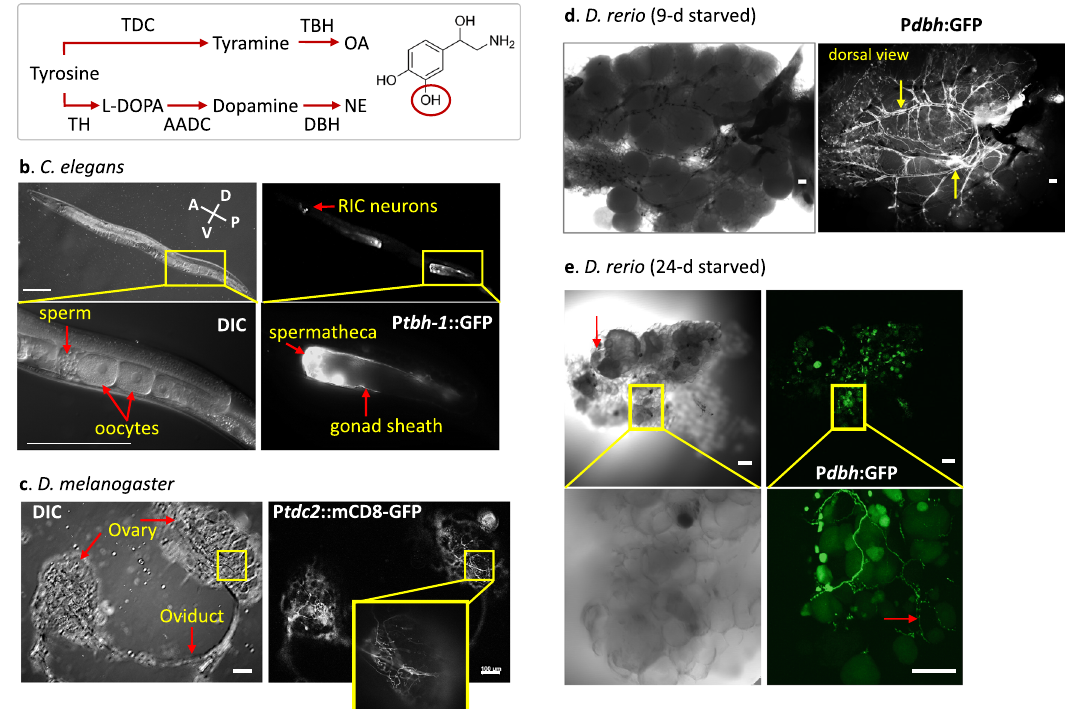
Fig. 1 Noradrenergic innervation of ovaries in the three animals. a The synthesis pathways of norepinephrine (NE) and octopamine (OA) and the enzymes for each step. TDC: Tyrosine decarboxylase, TBH: Tyramine β -hydroxylase, TH: Tyrosine hydroxylase, AADC: Aromatic L-amino acid decarboxylase, DBH: Dopamine β -hydroxylase, L-DOPA: L-Dihydroxyphenylalanine. NE is shown. The hydroxyl group (red circle) is absent in OA. b GFP driven by a tbh-1 promoter (P tbh-1 ::GFP) is expressed in the gonadal sheath cells and the spermatheca in addition to RIC interneurons in the head of a 1-day old adult C. elegans . All 15 C. elegans examined showed similar expression pattern. The left panel shows developing oocytes surrounded by gonadal sheath (top) and the enlarged image of the inset in a DIC image (bottom). The right panel shows the GFP expression of tbh-1 . The highest expression is observed in the spermatheca and the proximal three pairs of the gonadal sheath cells that surround diakinesis-staged oocytes. GFP is also expressed in a pair of RIC neurons in the head. c The expression of a tdc2 - GAL4 reporter with a membrane targeting mCD8-GFP marks OA-expressing ovarian neurons originated from the abdominal nerves in a virgin female D . melanogaster . The neuronal branches cover the entire surface of the ovary. Similar tdc2 -expression was observed from 18 fl ies. d EGFP driven by a dbh promoter is expressed in dbh -expressing neurons that surround the entire surface of the ovary in D. rerio . An image from a light microscopy shows many mature and growing oocytes in the ovary of 9-day starved zebra fi sh. The dbh -expressing nerves run along the main vasculatures on the dorsal side of the ovary (arrows). Similar dbh -expression was observed from 8 fi sh. e DIC and confocal images of the ovary of a 23-d-starved zebra fi sh. Degenerating oocytes are shown (red arrow). A higher magni fi cation image (bottom) shows small-sized varicosities along the neurons (red arrow). Similar dbh -expression at lower magni fi cation was observed from four fi sh. b – e Scale bar = 100 µ